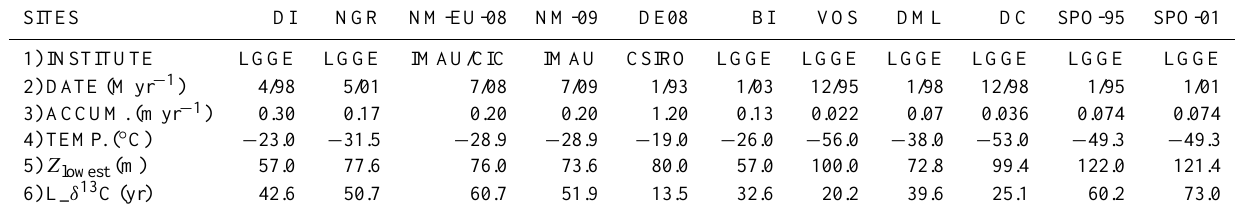
al., 2009), which strongly reduce molecular diffusivity with depth. The SH data show larger differences between the sites, ture, snow accumulation, snow morphology, etc.) in Antarc- tica differ strongly from site to site.